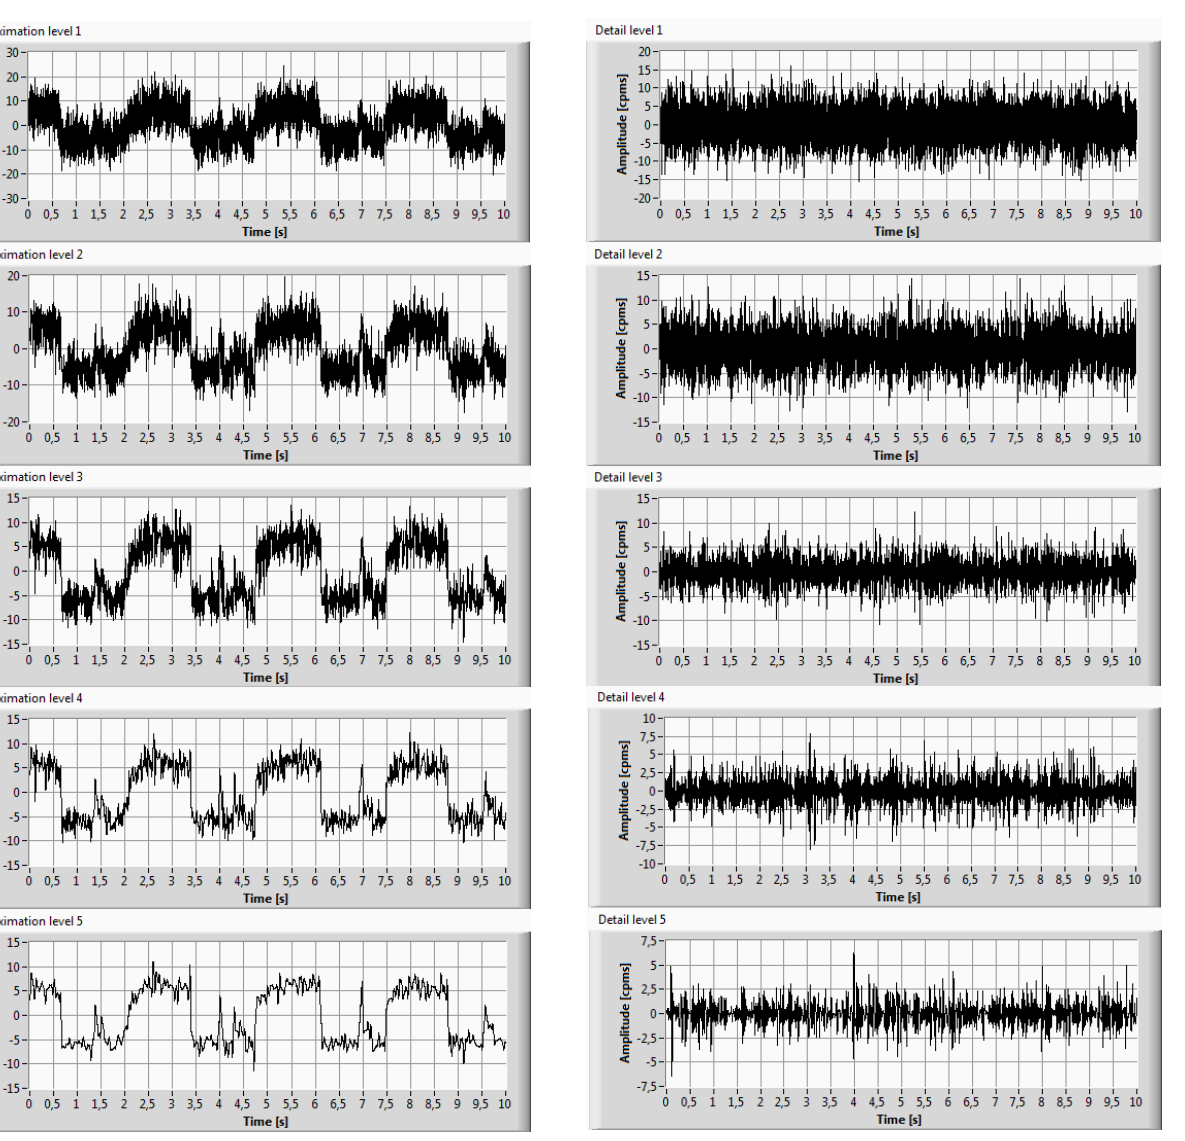
Fig. 5. An example of signal decomposition by the DWT. The operator ↓ 2 means down-sampling by two [19].